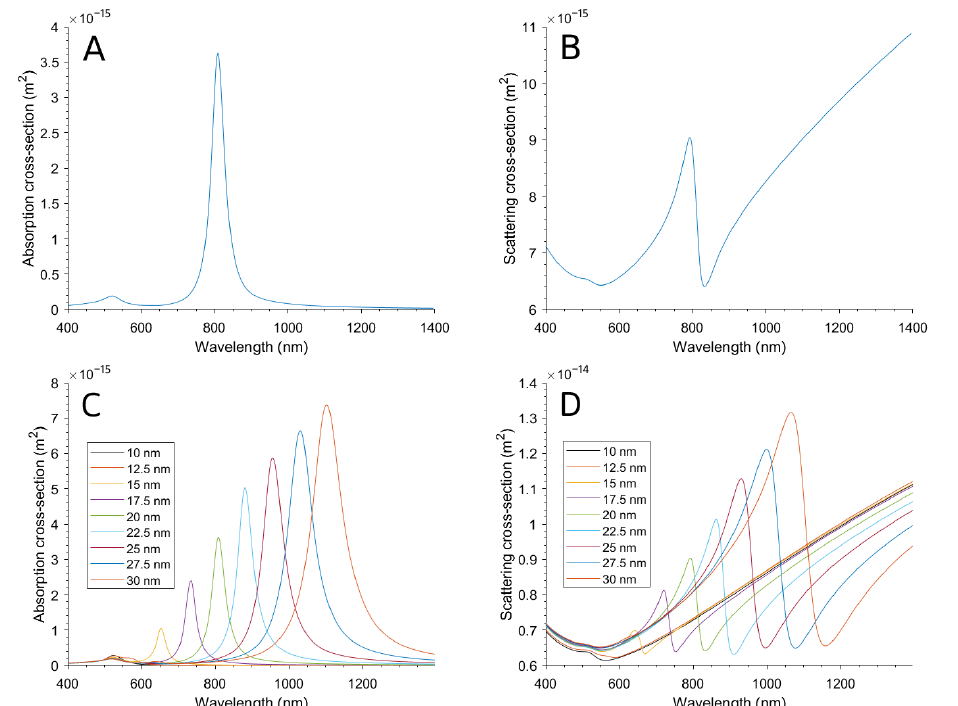
Figure 6. ( A ) Absorption and ( B ) scattering cross-sections of the NanoStar with tip length fixed to 20 nm. ( C ) Absorption and ( D ) scattering cross-sections varying tip lengths between 10 and 30